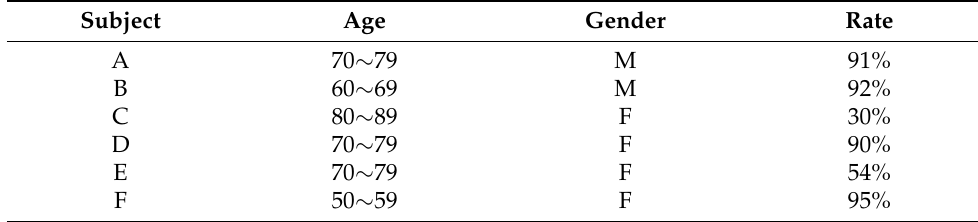
Table 3. Total response rate of elderly